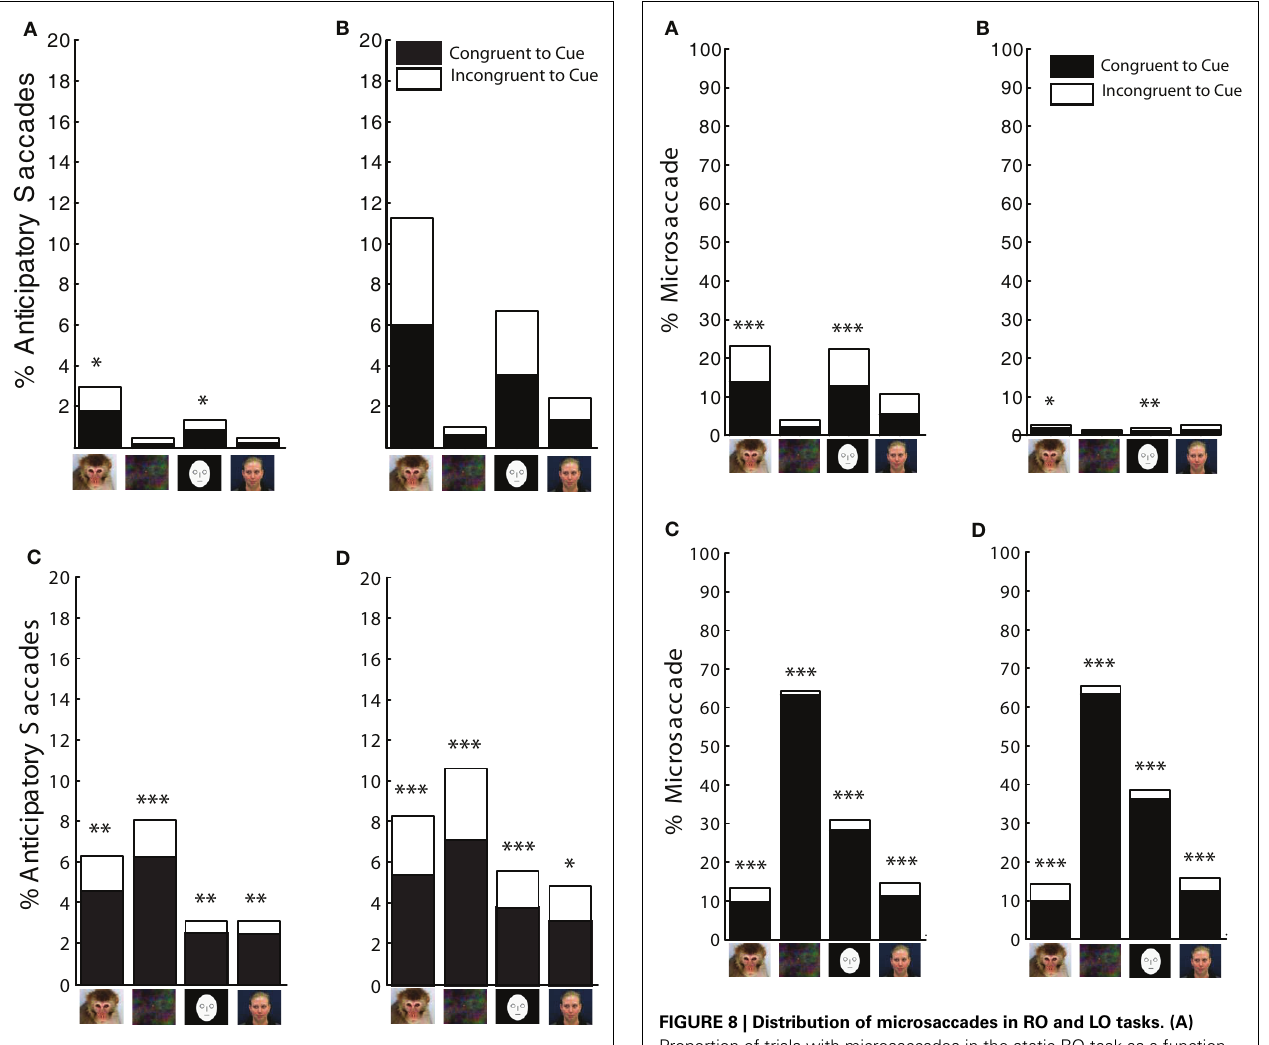
FIGURE 7 | Distribution of anticipatory saccades in RO and LO tasks. (A,B) Percentages of anticipatory saccades in the RO task for static trials (A) and dynamic trials (B) . Binominal tests showed that for static monkey-face cues and cartoon-face cues, anticipatory saccades were significantly more likely to be in the cued direction (* p < 0.05, ** p < 0.01, *** p < 0.001). (C,D) Compared to the RO task, the LO task elicited higher percentages of anticipatory saccades for all stimulus types in the 0 distractor (C) and 1 distractor condition (D) . Anticipatory saccades were significantly more likely to be in the cued direction regardless of cue type.